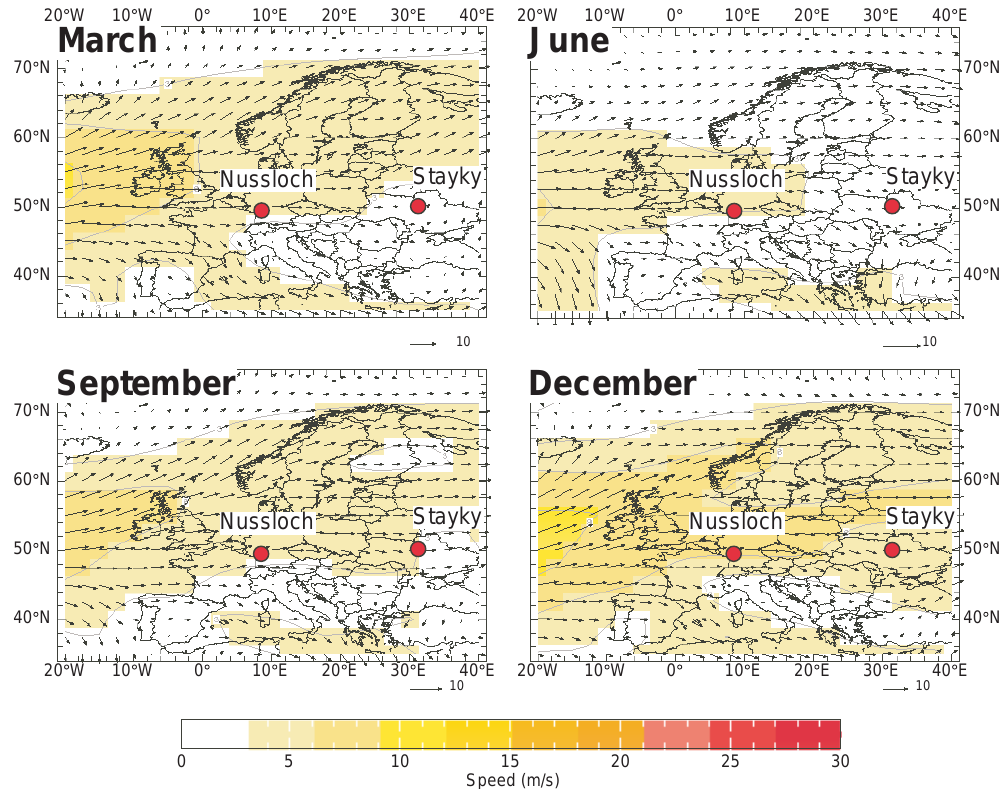
Fig. 1. Impact of Atlantic climate conditions over Europe. Modern monthly average wind speed, in ms − 1 , at 850Hpa pressure level for March, June, September and December over Europe. Wind vectors plotted over shading and contours at 3ms − 1 interval. Nussloch and Stayky are two sequences cited in the text. Data source: NCEP reanalysis monthly wind components on a 2.5 × 2.5 ◦ long/lat grid for